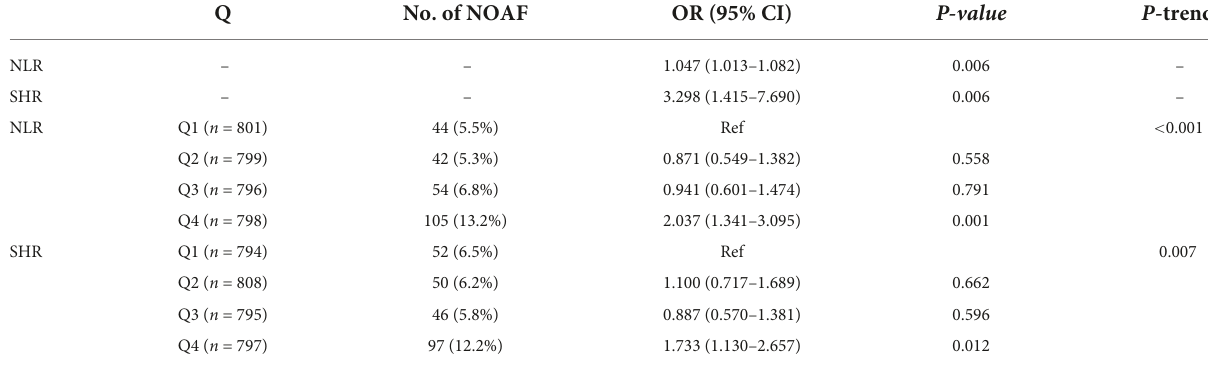
TABLE 2 The prevalence of new-onset atrial fibrillation (NOAF) and the risk estimate for NOAF based on the Q of stress hyperglycemia ratio